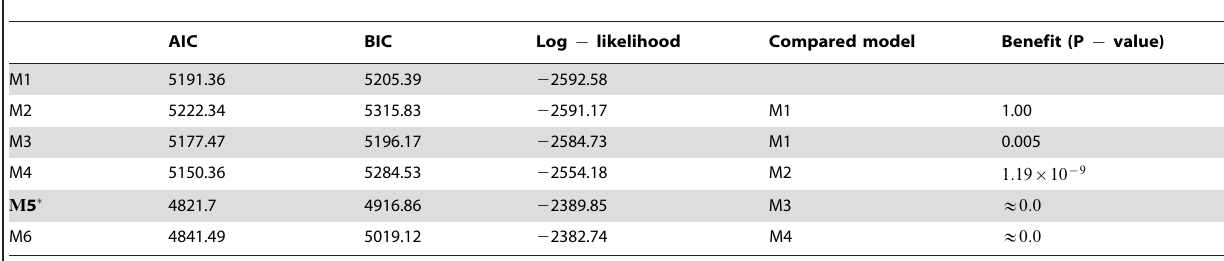
Table 2. Results of the analysis of 2009 H1N1 epidemic in Hong Kong.